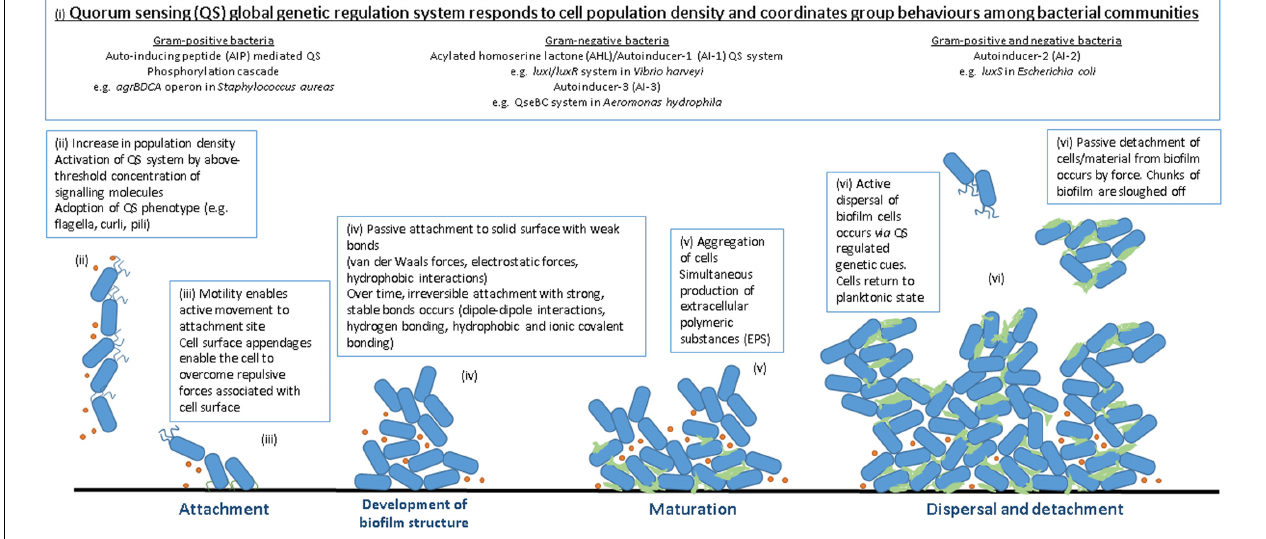
FIGURE 1 | Stages of biofilm formation. (i) QS signaling molecules (ii) high population density, high QS signal (iii) attachment to solid surface (iv) increase in cell numbers, irreversible attachment, development of biofilm structure (v) biofilm maturation and EPS production (vi) dispersal.